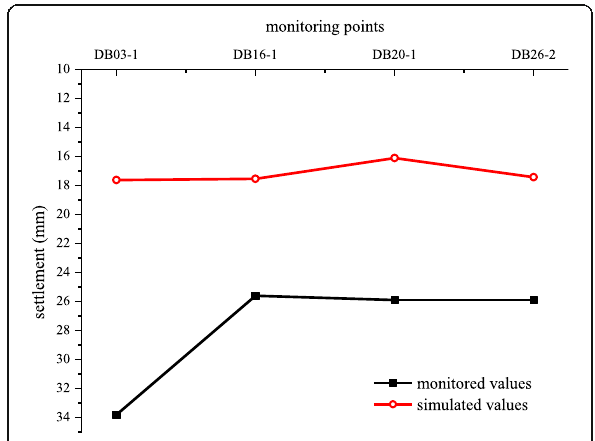
Fig. 9 Monitored and simulated settlements